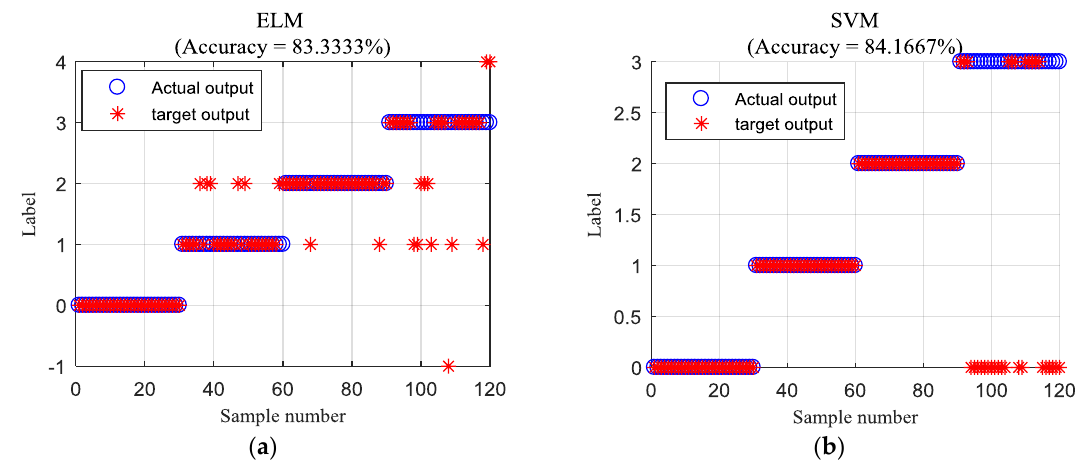
Figure 19. The classification results of ( a ) extreme learning machine (ELM); ( b ) support vector machine